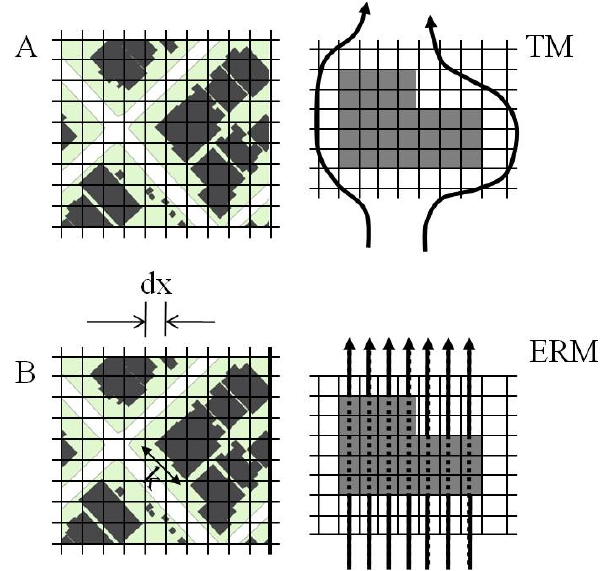
Fig. 5. Schematic descriptions of TM and ERM in residential area, (A) TM changes the direction of the flow due to the existence of the building. (B) ERM will significantly reduce the flow velocity (dotted line) when the tsunami passes through the building as the effect of the equivalent